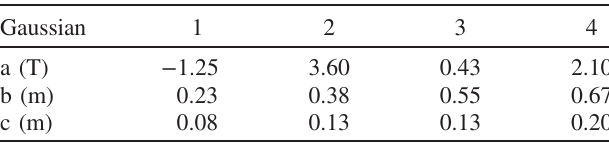
TABLE I. Coefficients of four Gaussian functions. Gaussian